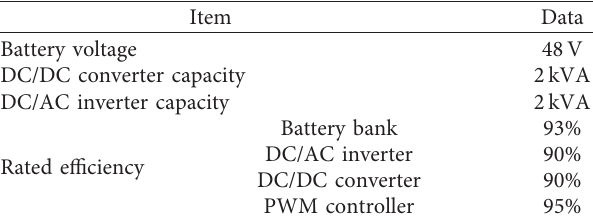
Table 5: Summary of detailed technical data of equipment.